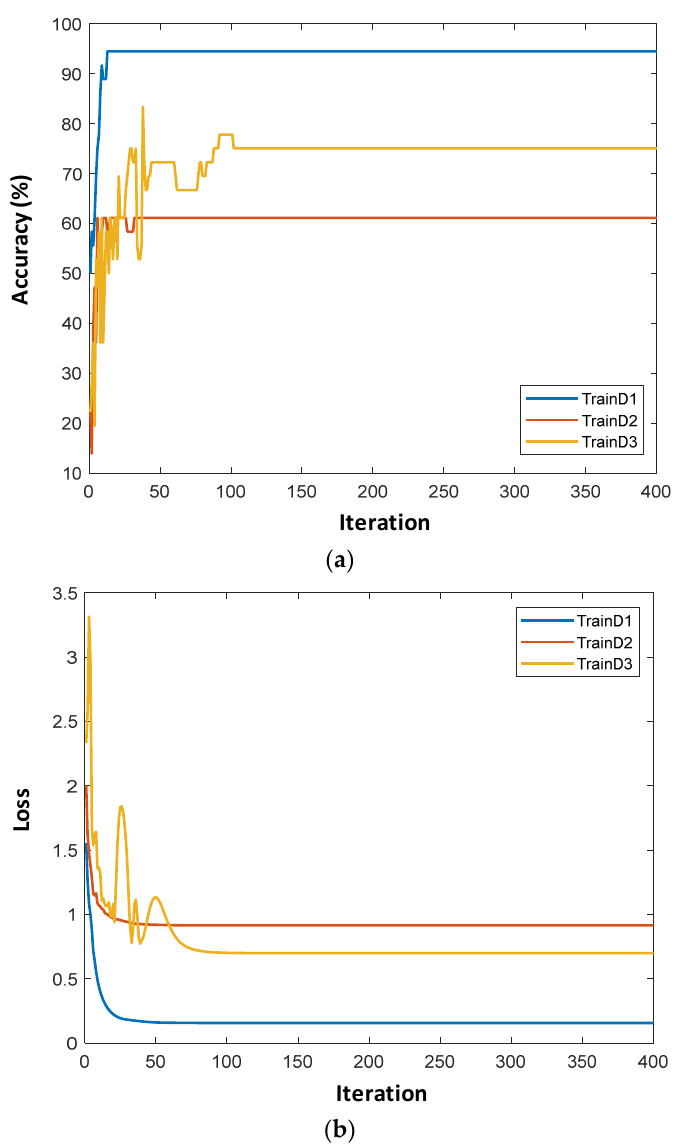
Figure 16. The training accuracy and the training loss of the 1D CNN. ( a ) Training accuracy; ( b ) Training loss.